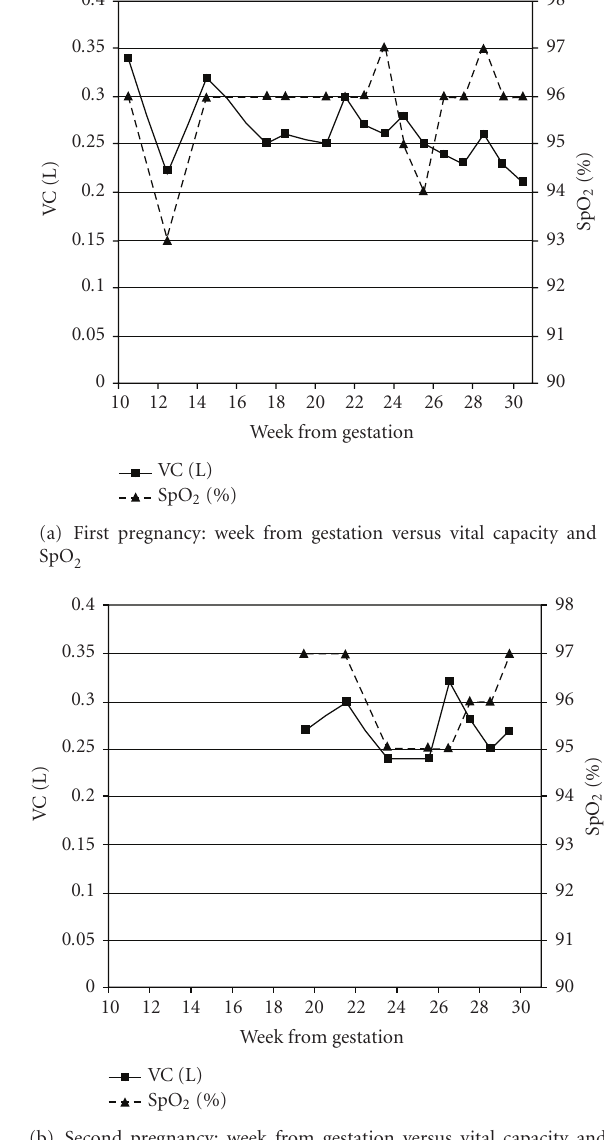
Figure 1: Vital capacity (VC) (solid line) and room air oxygen ) (dashed line) measured at week from gestation saturations (SpO 2 for (a) the first and (b) the second